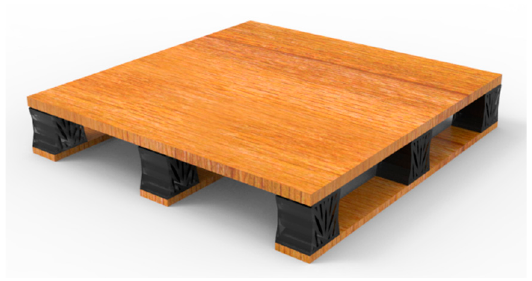
Figure 17. The application of bionic structure in